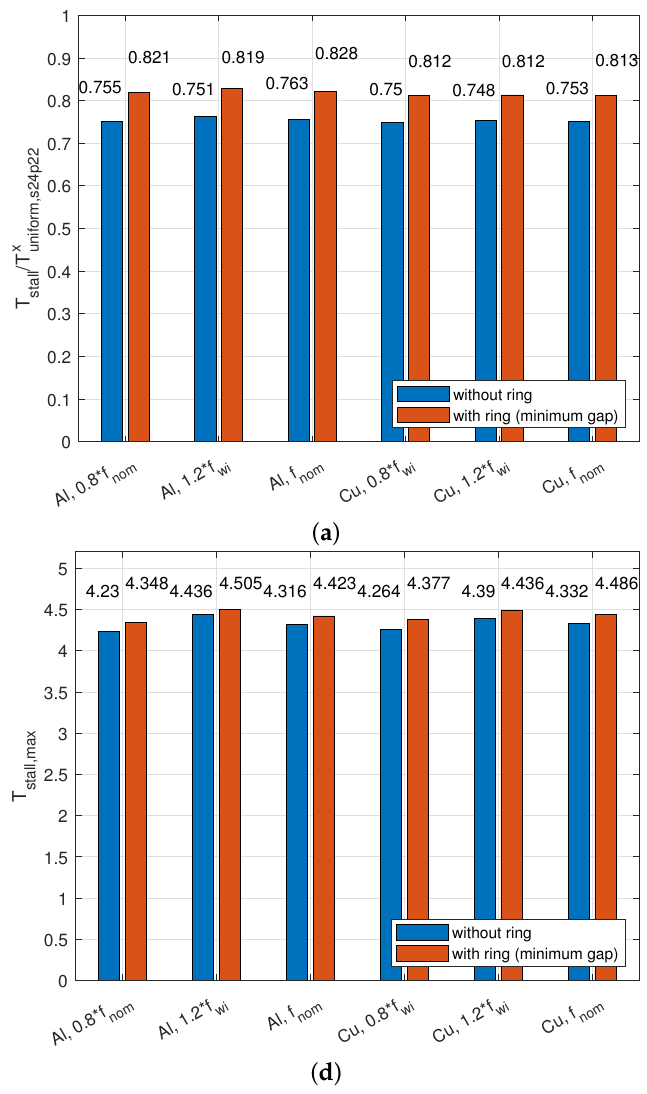
Figure 18. Simulated ( a ) torque derating factor T stall / T x ( b ) maximum stall torque, for different values of f Al and 22 or 26 poles combination, and for the case with and without thermal end-winding ring. ( a ) Simulated torque derating factor T stall / T uniform,s24p22 . ( b ) Simulated maximum stall torque (@ T hotspot = 150 ◦